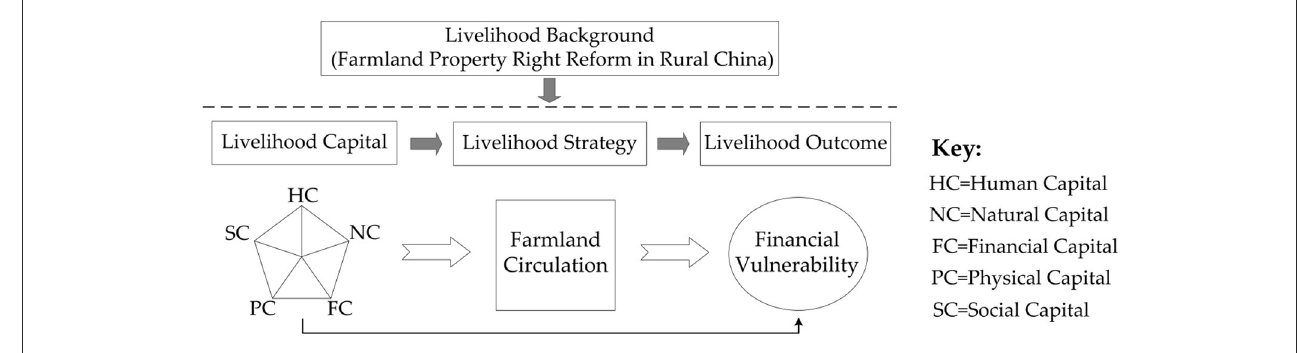
FIGURE2 Farmland circulation and household financial vulnerability: Based on the